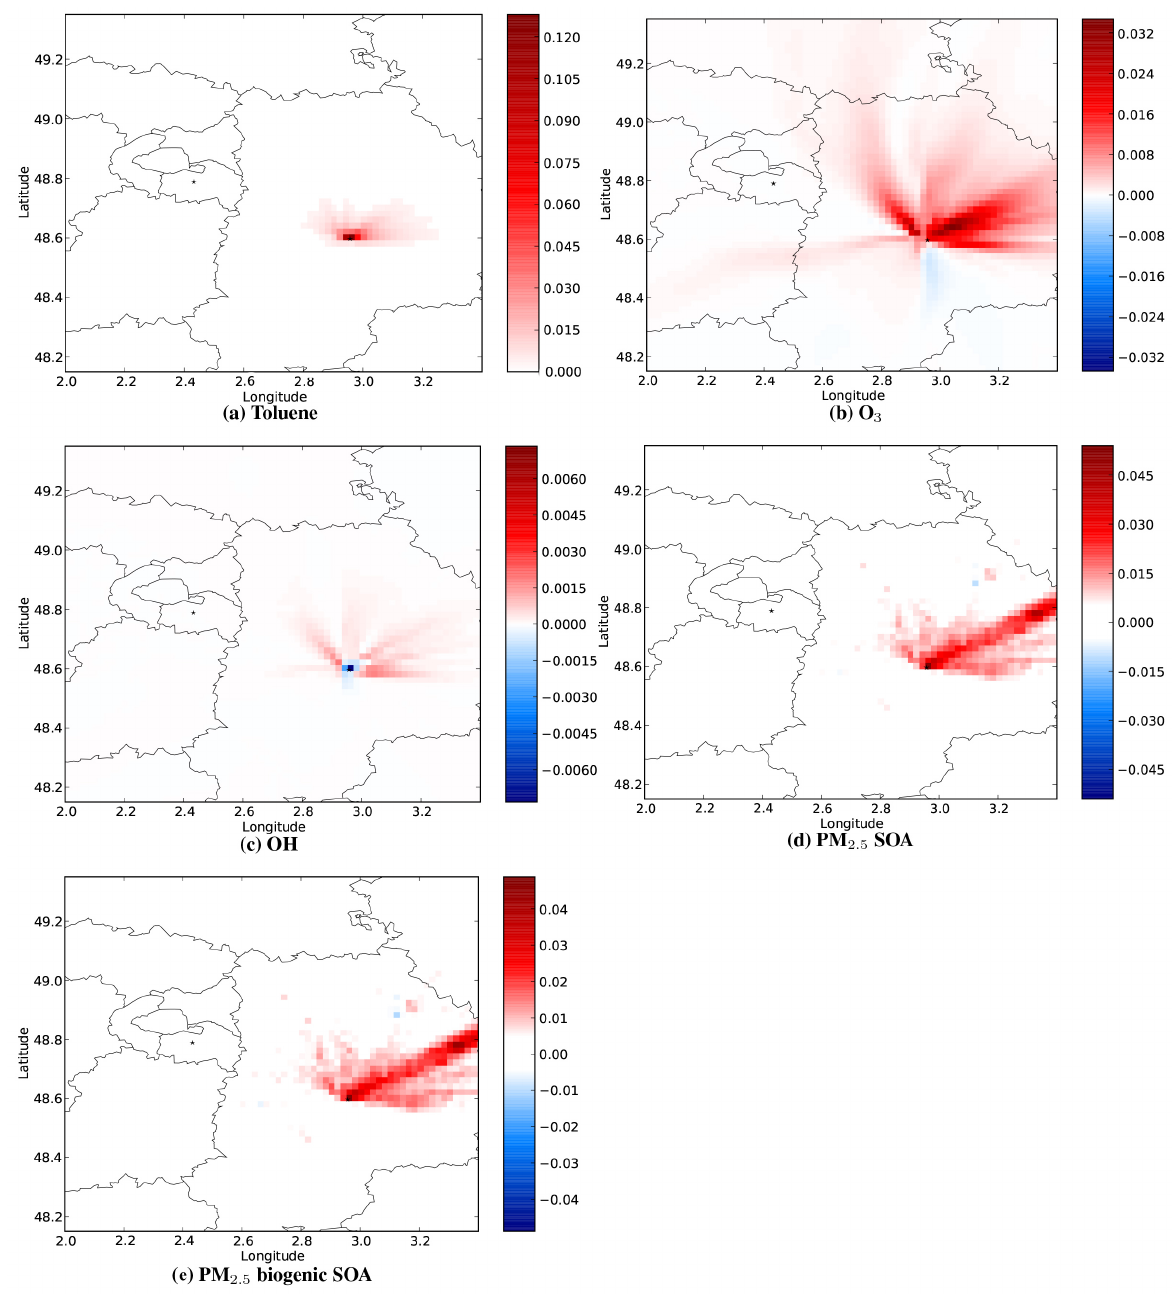
Fig. 6. Differences (PinG – PinG-NonVolumeSource) in mean surface concentrations for 4–29 July 2009 over the Greater Paris domain: (a) Toluene (ppb), (b) O 3 (ppb), (c) OH (ppt), (d) PM 2 . 5 SOA (µgm − 3 ), (e) PM 2 . 5 biogenic SOA (µgm − 3 ).